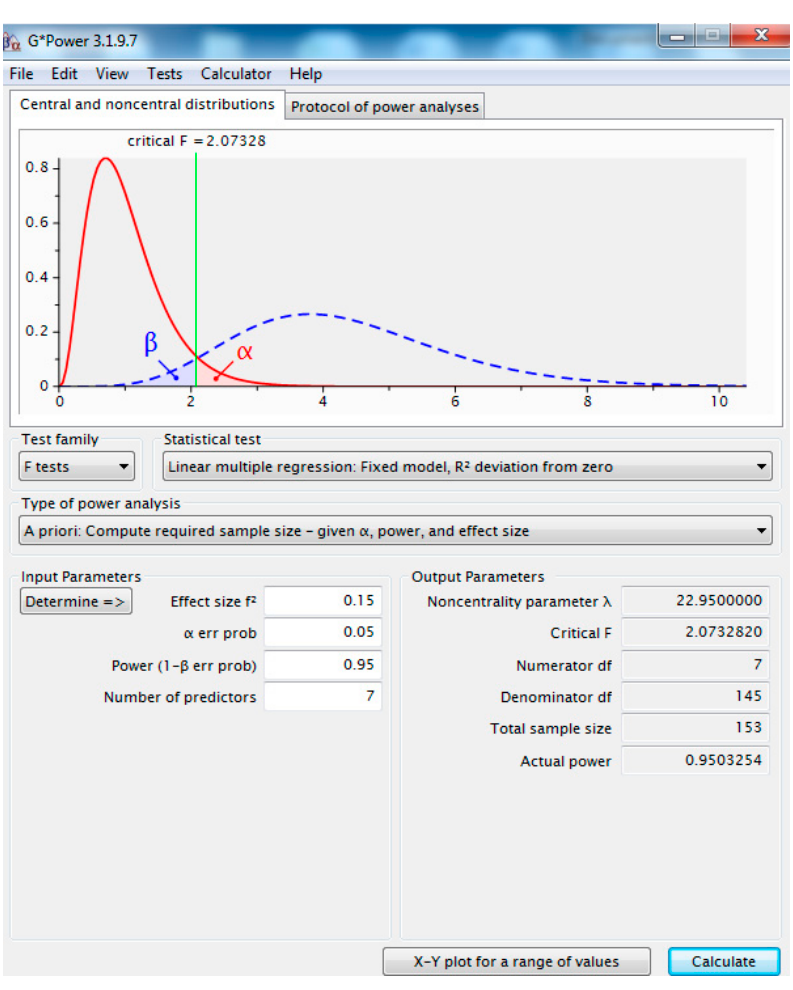
Figure 2. Sample size calculation using G Power 3.1.9.7.